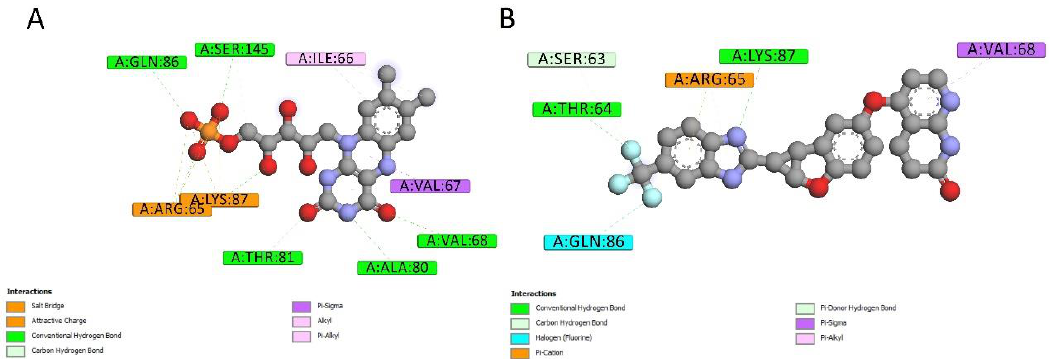
Figure 5. 2D ligand – protein interactions for Lifirafenib and co-crystallized ligand in aroQ. ( A ) 2D interactions between 3DS and aroQ. ( B ) 2D interactions between Lifirafenib and aroQ.